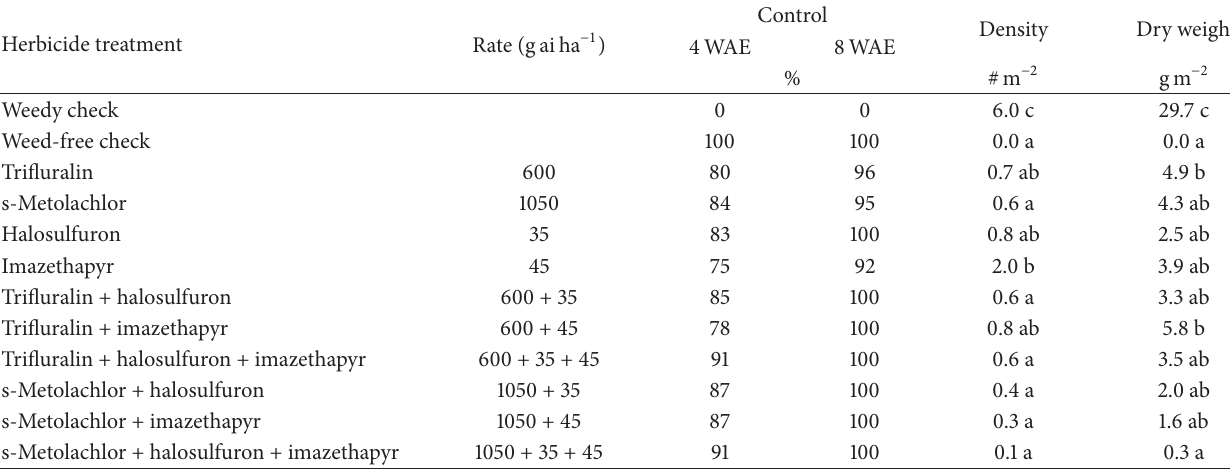
Table 2: Percent control, density, and dry weight of redroot pigweed in white bean treated with halosulfuron tankmixes applied PPI at Exeter (2011-2012) and Harrow, ON (2012). Means followed by the same letter within a column are not significantly different according to Fisher’s Protected LSD at 𝑃 < 0.05 a